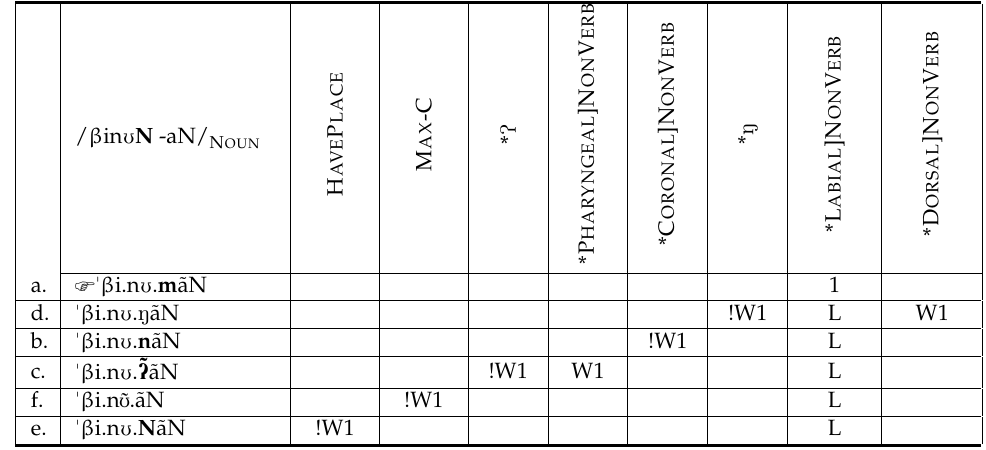
Table 4. /kap ɨ C -aN/ → [ ˈ ka.p ɨ . p ãN] ‘alligator’ (/N/form)—Capanahua. Tableau 6: /βinʊ N -aN/  [ˈβi.nʊ. m ã N] ‘aguaje’ (/-N/ form) - Shipibo-Konibo Table 6. in U N -aN/ → [ " β i.n U . m ã N] ‘aguaje’ (/-N/form)—Shipibo-Konibo.